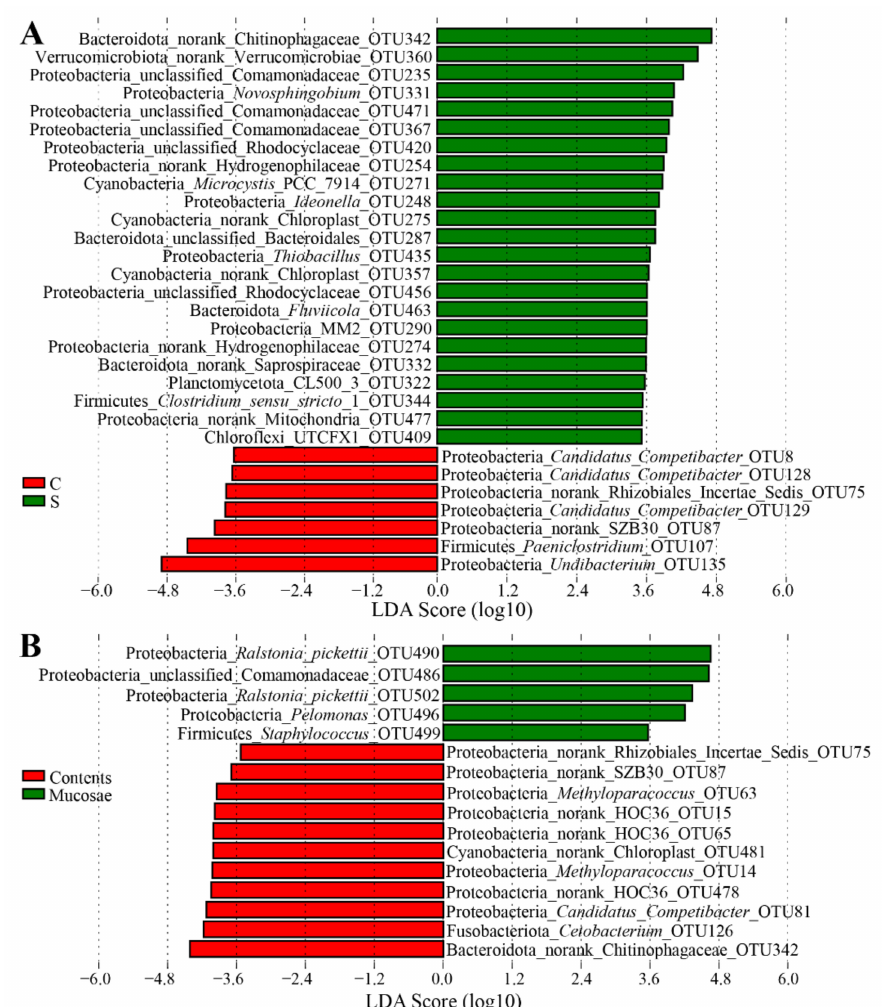
Figure 5. ( A ) LEfSe showing differences in the bacterial communities at the OTU level between the stomach contents and contents. ( B ) LEfSe showing differences in the bacterial communities at the OTU level between the content (C and S) and mucosa (G, M, and W) samples. The highlighted taxa are enriched in the group that corresponds to each color. LDA scores can be interpreted as the degree of difference in the relative abundance of